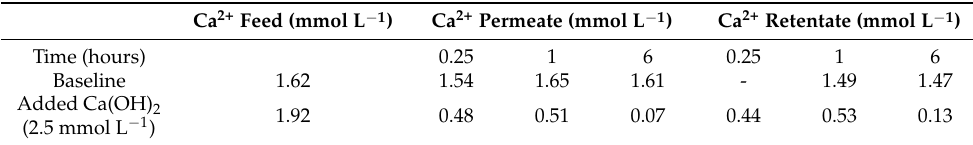
Table 5. Calcium concentrations in the feed, permeate, and concentrate